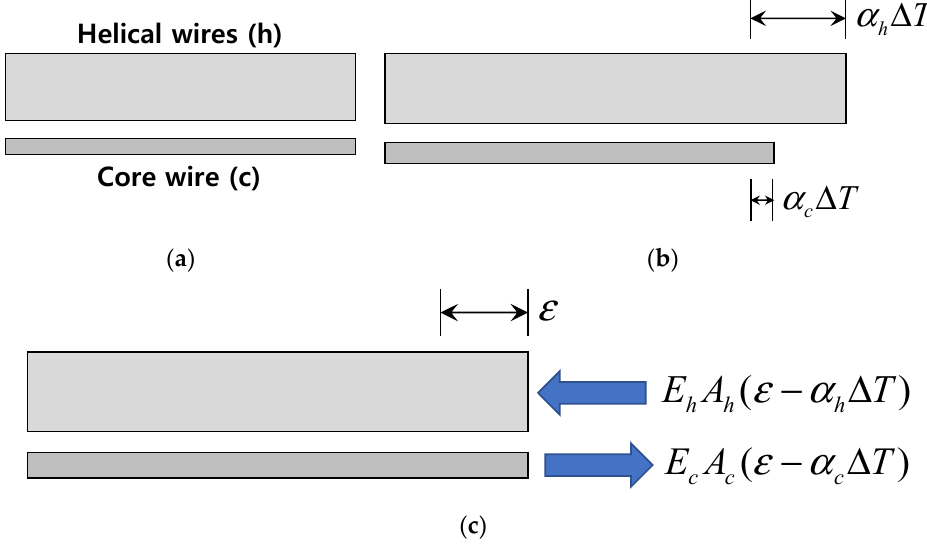
Figure 3. Thermal behavior of a core wire and helical wires in a Smart Strand: ( a ) before the length change; ( b ) length change without restraint; and ( c ) length change with restraint (actual situation). Therefore, the mechanical strain of the Smart Strand can be represented by Equation